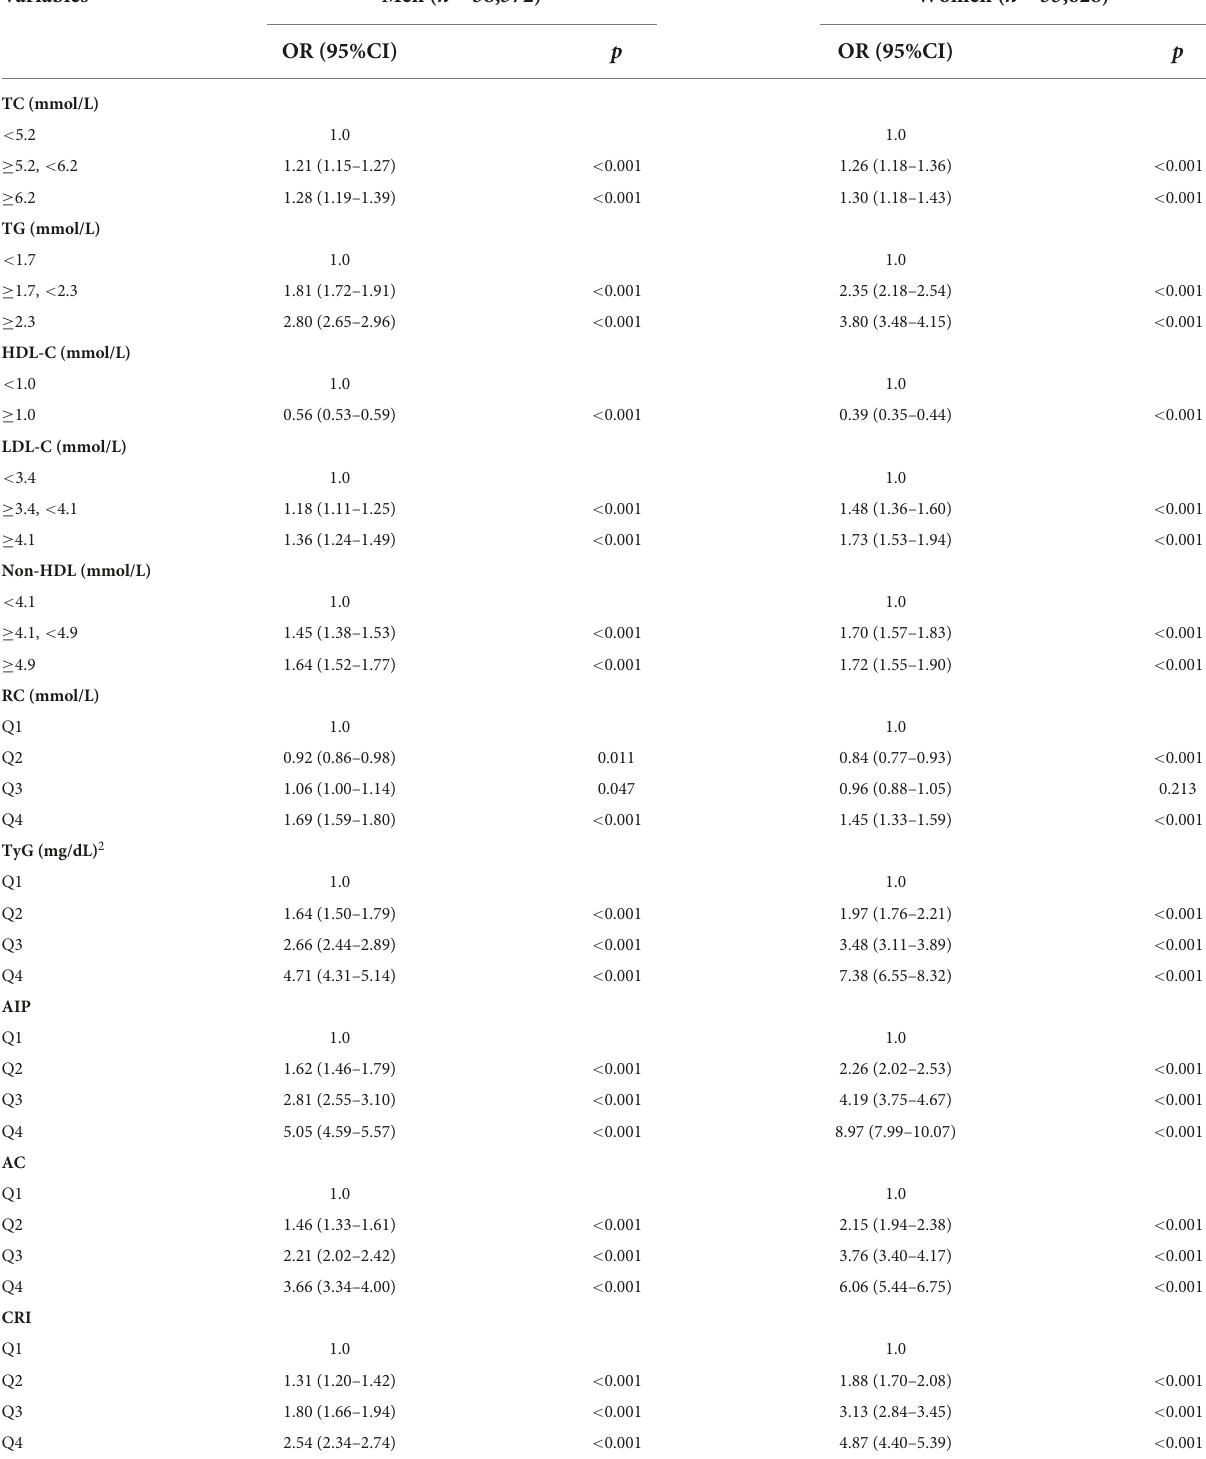
TABLE 3 Multivariate logistic regression analysis of lipid parameters with NAFLD in men and